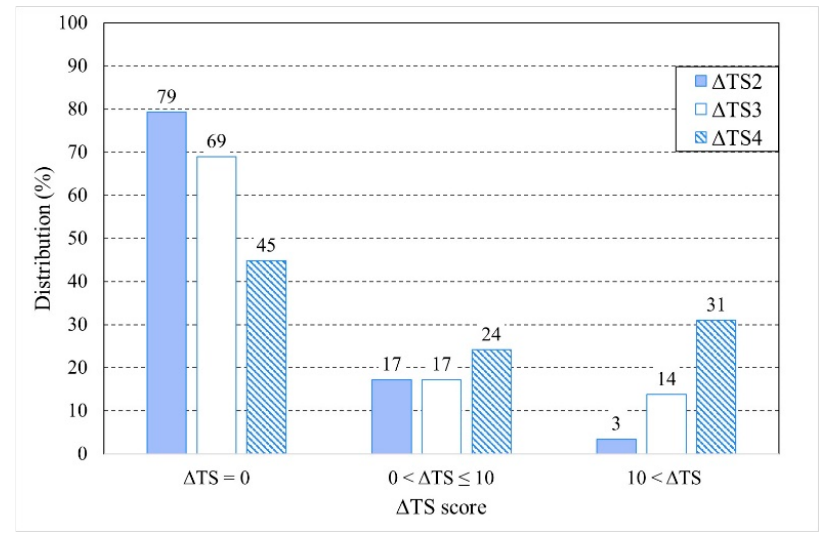
Figure 10. Grouped Scatter of “Event” by “Percentage of attention time”. 4. Results 4.1. Questionnaires Results The SSQ questionnaire was filled at four different moments during the experimental sessions, as described in the previous section. The initial response (TS1) was subtracted from each of the three later responses to obtain the change in total sickness measure ( Δ TS2, Δ TS3, and Δ TS4) as metrics to determine discomfort on the HMD (Figure 11).